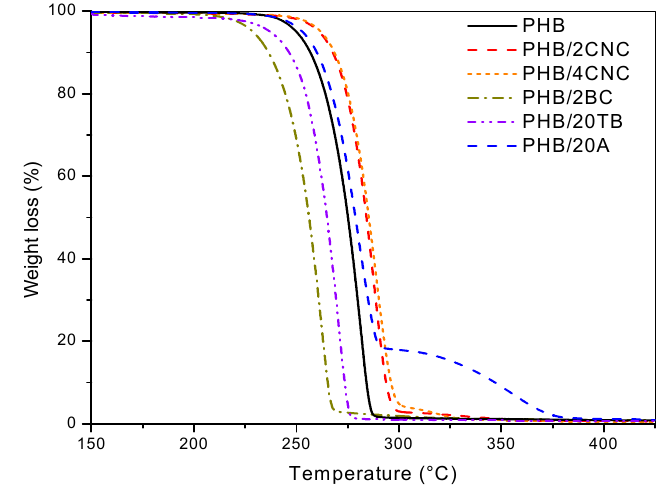
Figure 4. TGA curves of PHB and PHB binary samples.